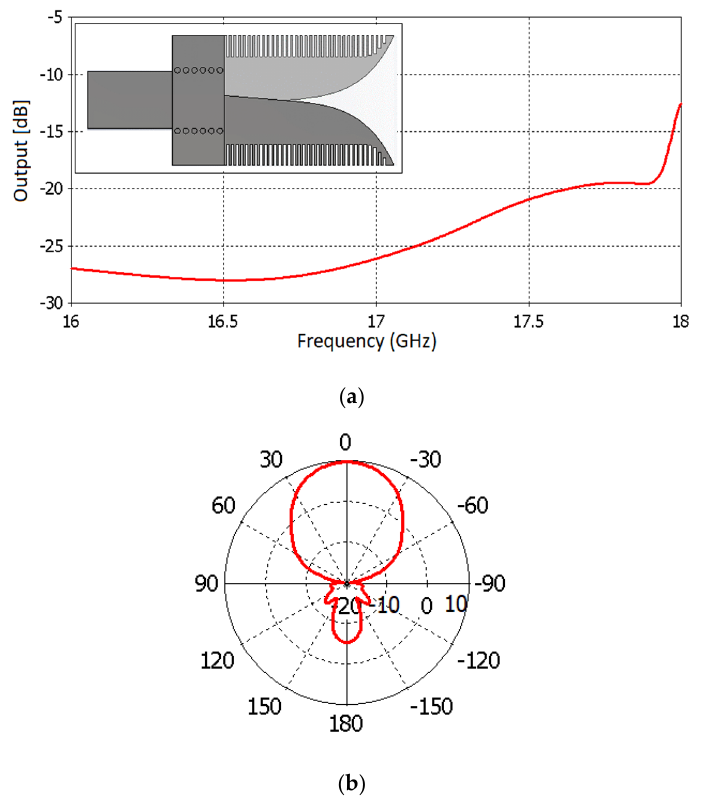
Figure 9. SIW Vivaldi antenna, ( a ) reflection coefficient, ( b ) far-field radiation pattern at 17 GHz.